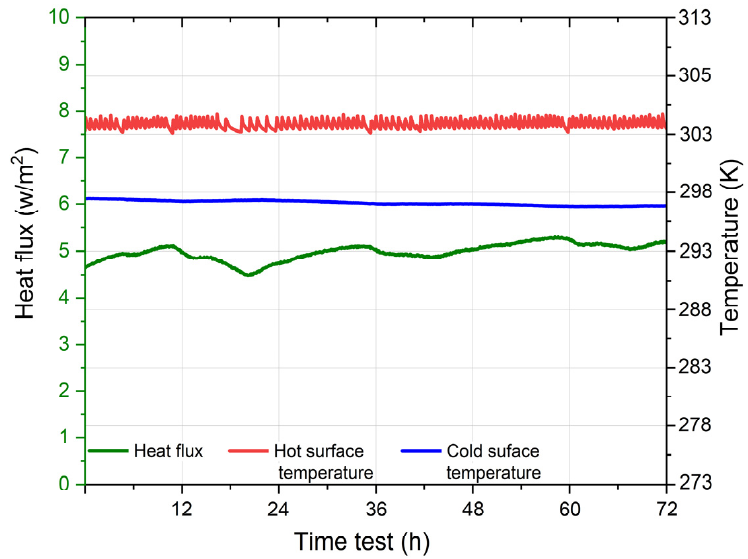
Figure 5. Hotbox test results for giant-reed board I-55.